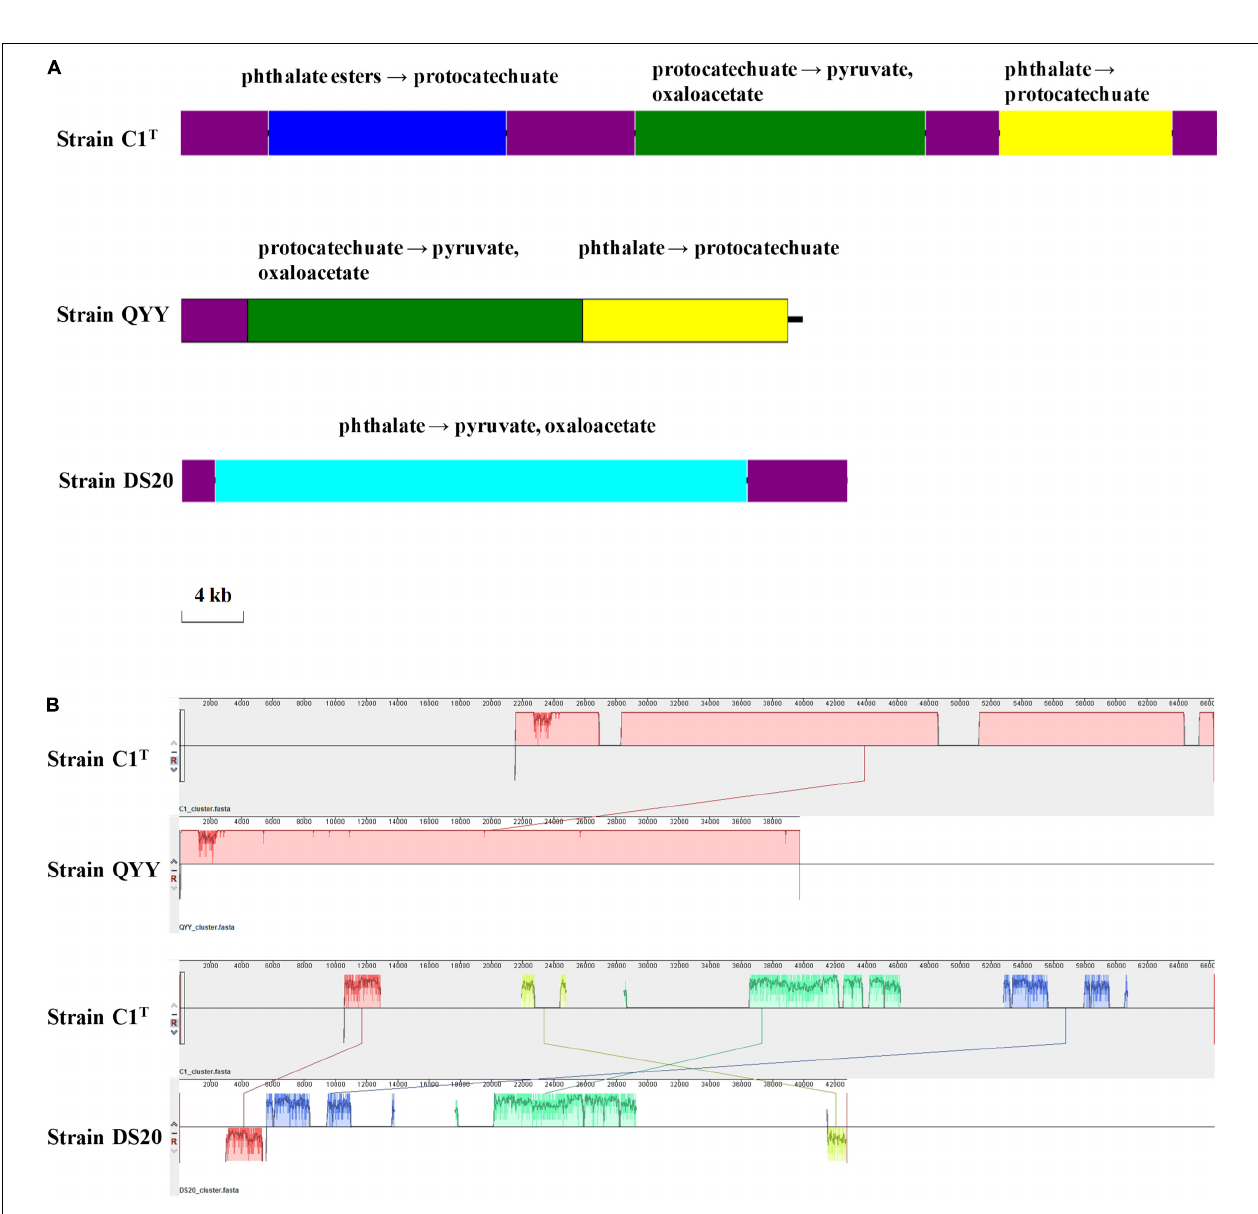
FIGURE 7 | The PAEs degradation gene clusters of strains C1 T , QYY and DS20. (A) Organizations of these gene clusters. The purple blocks represent ISs. Other blocks contain genes responsible for corresponding metabolic processes. (B) Homologous regions between these gene clusters detected by Mauve. The image scales of (A,B) are the